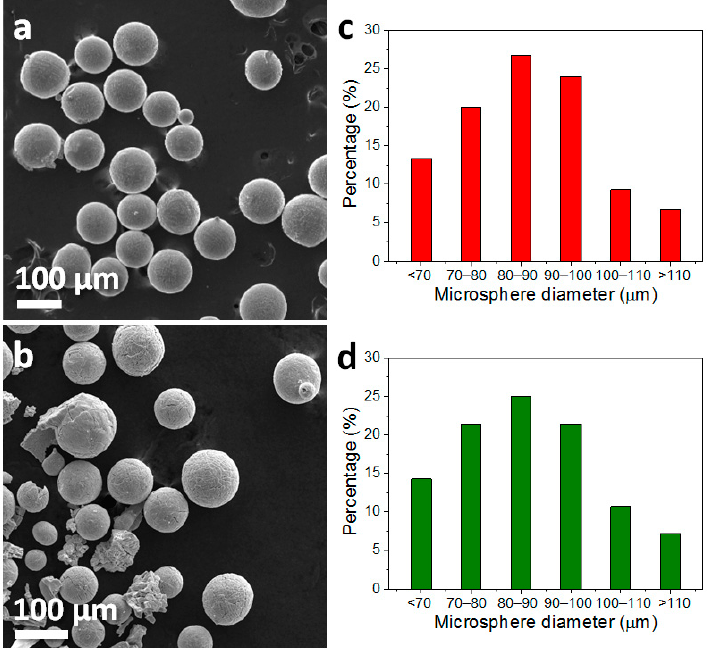
Figure 5. SEM images of the precursor microspheres ( a ) and the dealloyed microspheres ( b ). Corresponding size statistics of microspheres before ( c ) and after ( d ) dealloying.